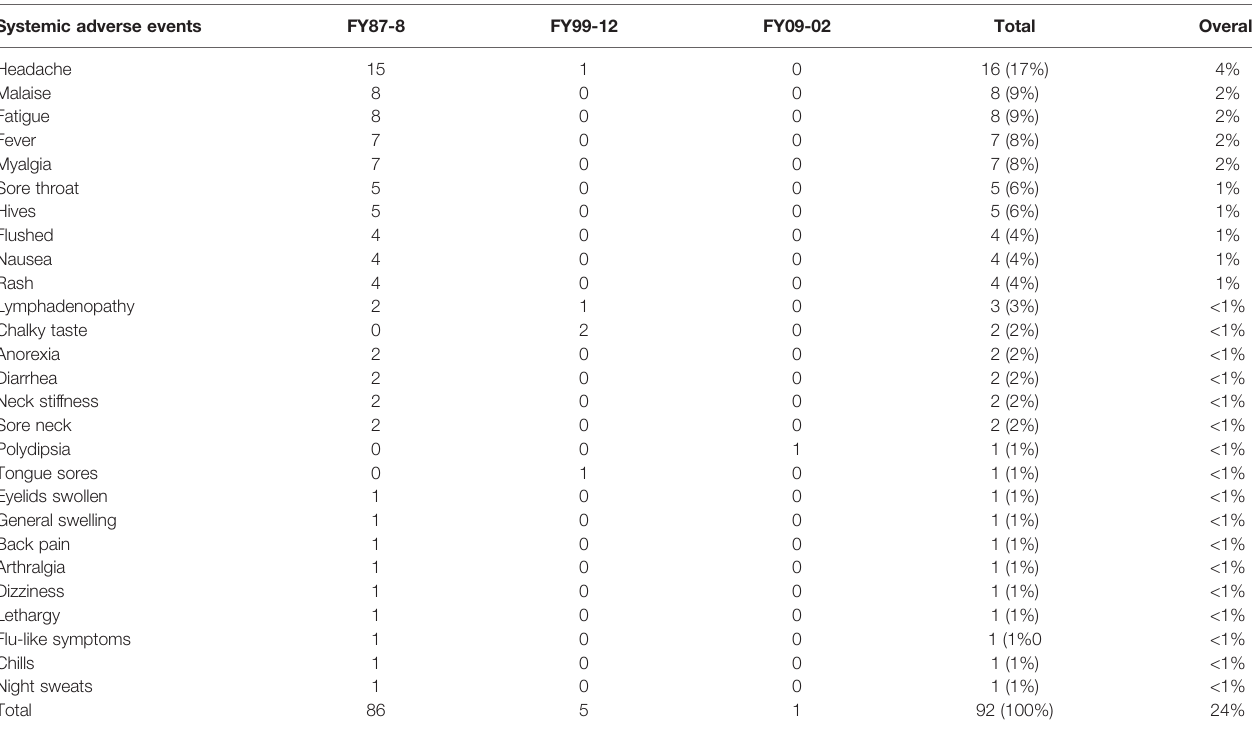
TABLE 6 | Systemic Adverse Events (AEs) de fi nitely related to the vaccine (1987 – 2011). Systemic adverse